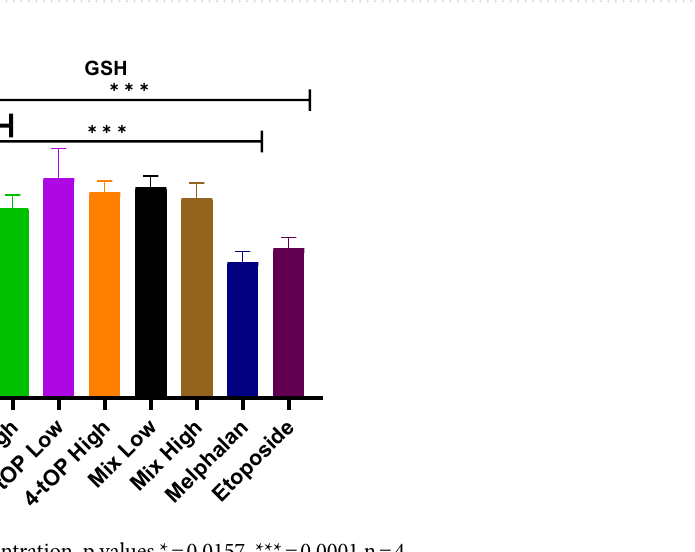
Figure 5. Glutathione concentration. p values * = 0.0157, *** = 0.0001 n =